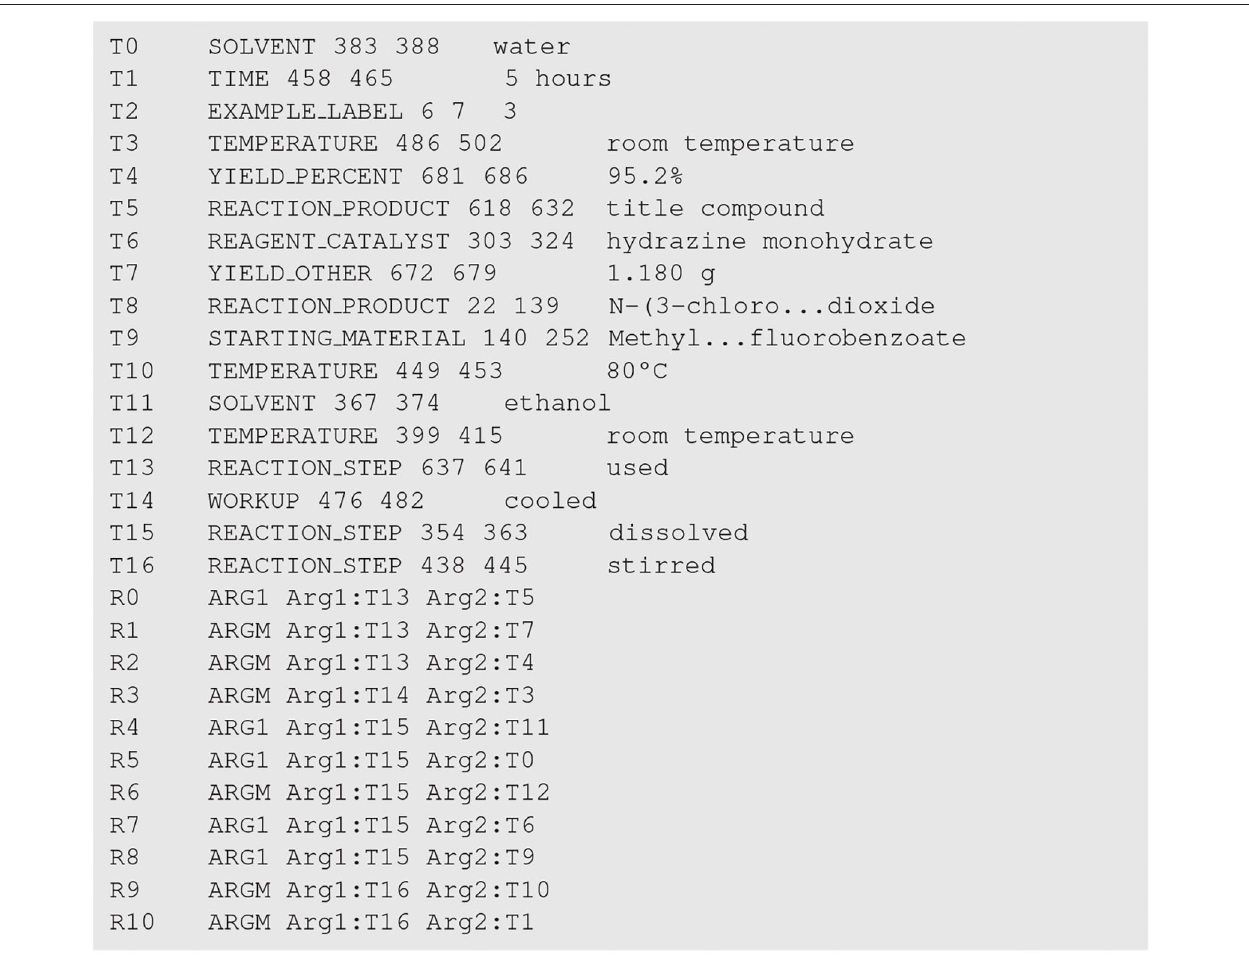
FIGURE 3 | The annotation file for the patent snippet in Figure 1 . Entities and trigger words are indexed from T0 to T16 , and relations are indexed from R0 to R10 .